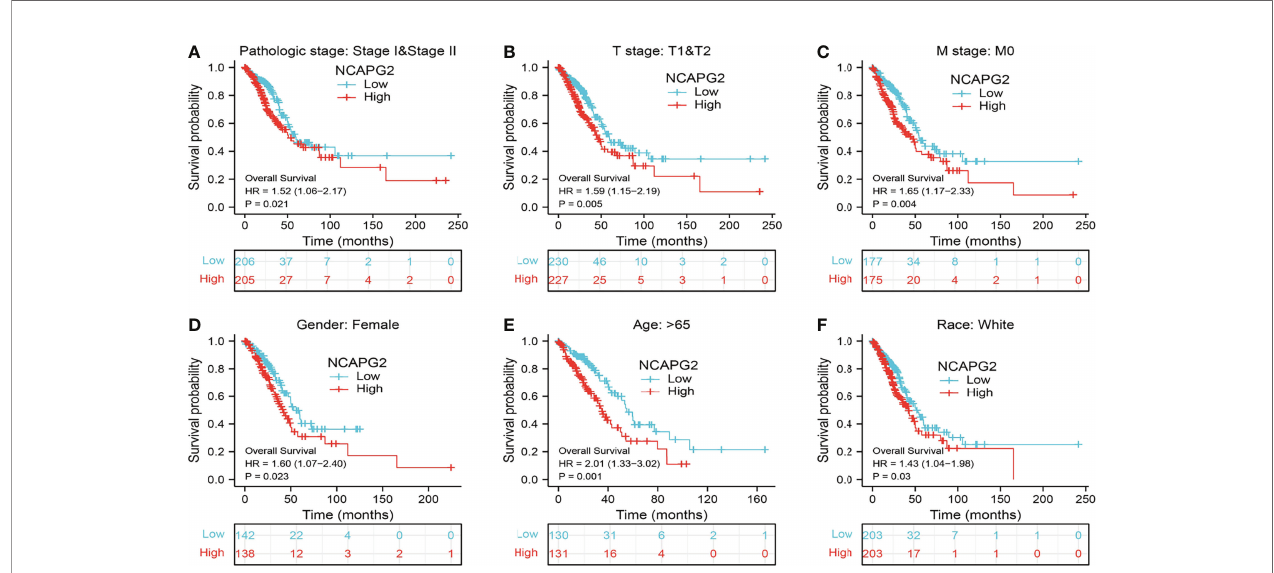
FIGURE 6 | Associations between NCAPG2 expression level and the overall survival in different clinical subgroups of LUAD in the TCGA database. (A) Stage I – II, (B) T1 – T2, (C) M0, (D) female, (E) age > 65, and (F) race,